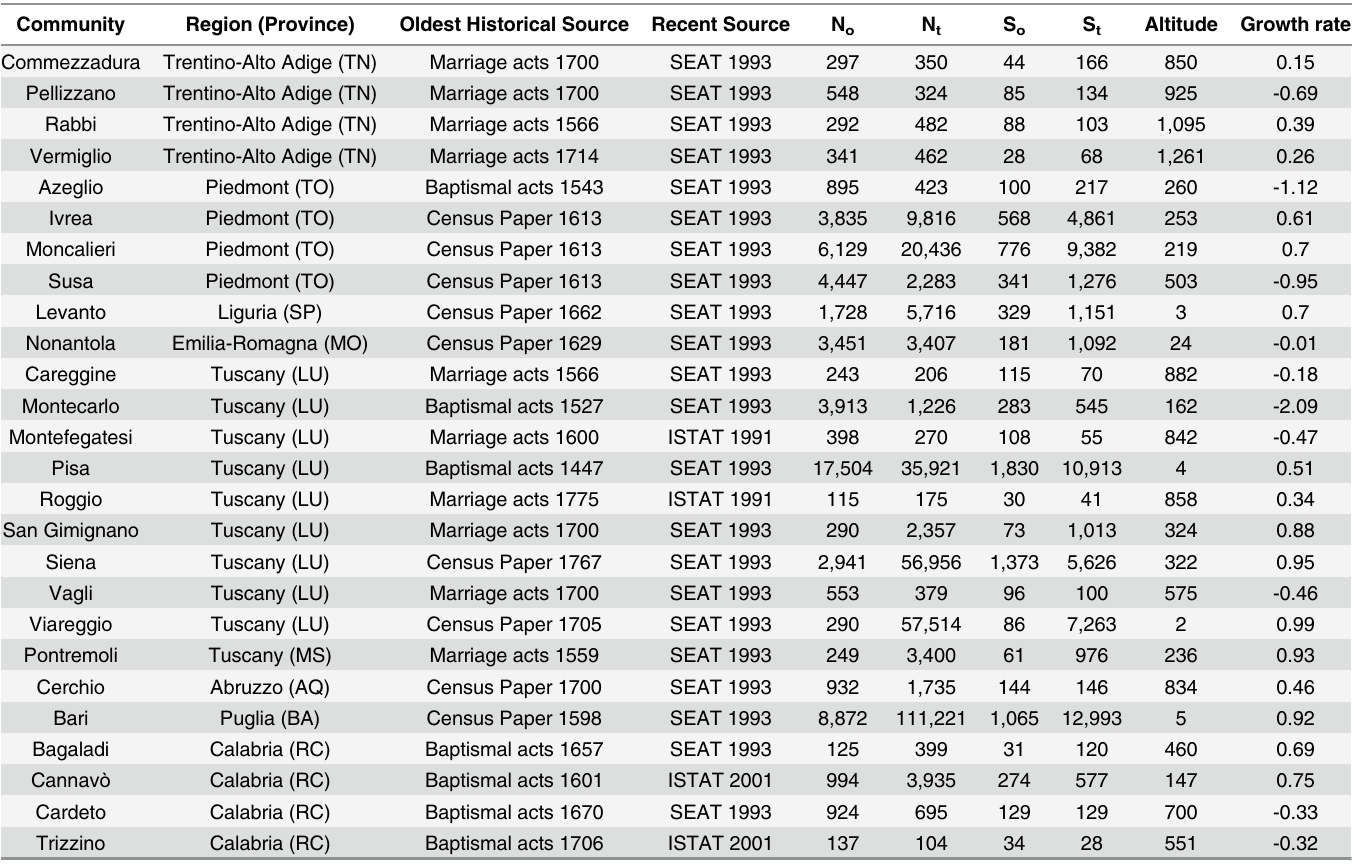
Table 1. Details of the studied communities/municipalities. N 0 , number of individuals of the oldest list of surnames; N t , number of individuals of the pres- ent-day list of surnames; altitude is indicated in meters above sea level; relative growth rate calculated as N t -N 0 /N t